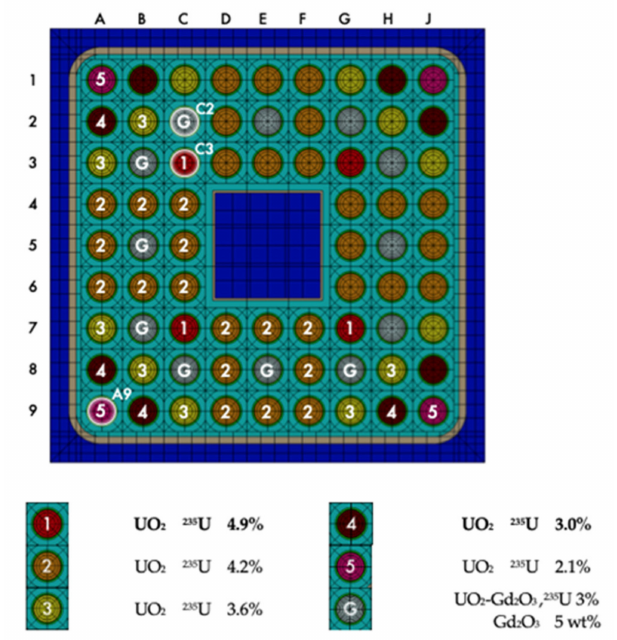
Figure 1. Illustration of the SCALE/Polaris assembly